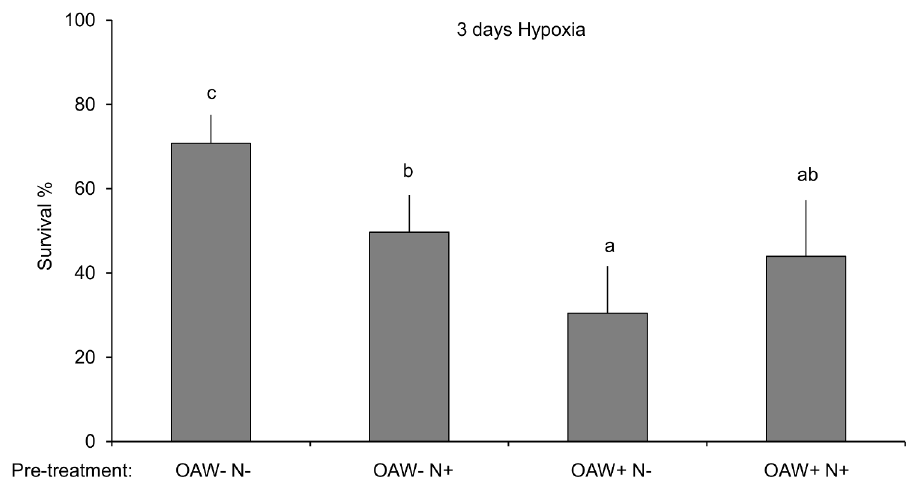
Fig 5. Survival of F . vesiculosus germlings after 3 days of hypoxic upwelling. Survival (%, mean +SD, n = 3) in 16 sibling groups of F . vesiculosus germlings previously treated under the four treatment combinations of the OAW x nutrient experiment: OAW-N-, OAW-N+, OAW+ N-, OAW+N+. Different letters above the bars indicate significant differences (p-value < 0.05) between the treatments after Tukey ’ s HSD.